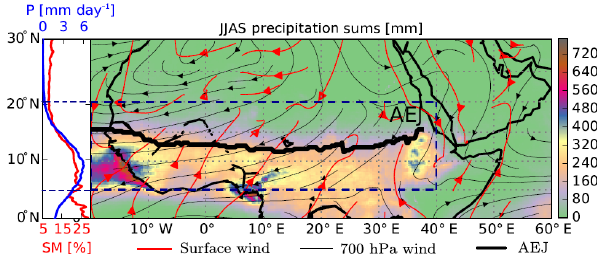
Figure 1. JJAS TMPA precipitation (shading), mean surface (red streamline) and 700hPa (black streamline) ERA-Interim (1979– present, Dee et al., 2011) wind climatology averaged over the 2002– 2011 period. The black thick line shows the mean location of the African easterly jet (AEJ). The inset plot to the left shows zonal means of daily AMSR-E soil moisture (red) and TMPA precipita- tion (blue) climatology calculated over the study domain (dashed rectangle, 5–20 ◦ N, 20 ◦ W–40 ◦